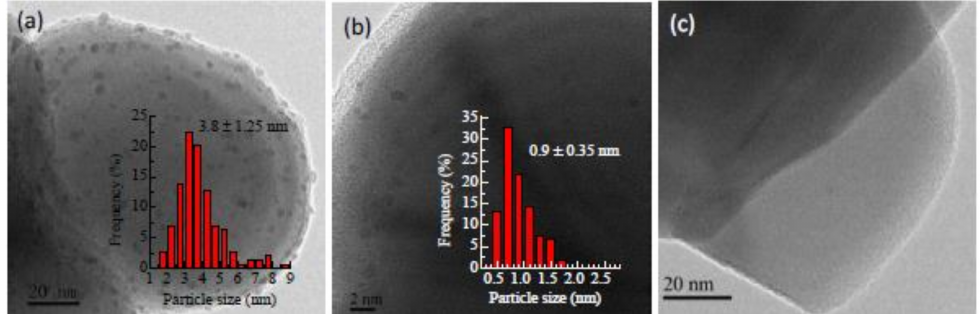
Figure 15. TEM images and particle size distributions of the catalysts: a —1%-Pd/ZnO; b —0.1%-Pd/ZnO; c —0.01%-Pd/ZnO reduced at 100 ◦ C (reproduced with permission from